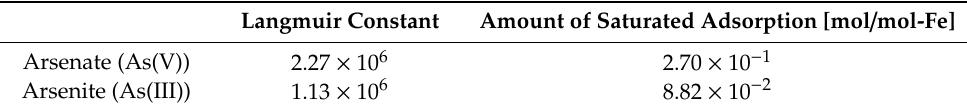
Table 2. The Langmuir constants of arsenite and arsenate adsorption on ferrihydrite. Langmuir